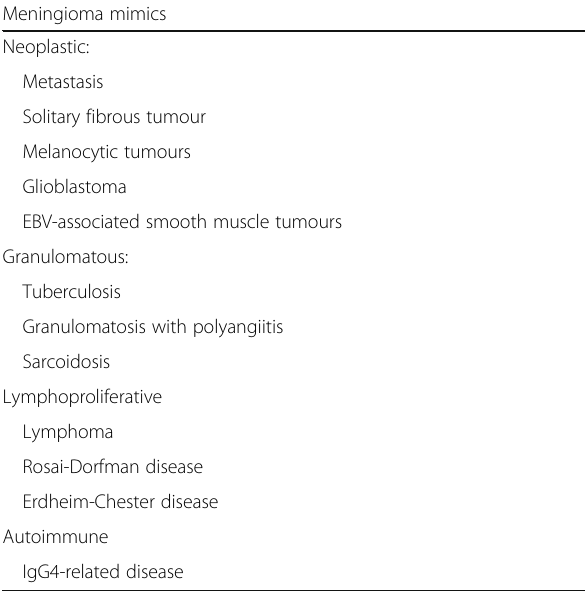
Table 1 Meningioma mimics in the literature Meningioma